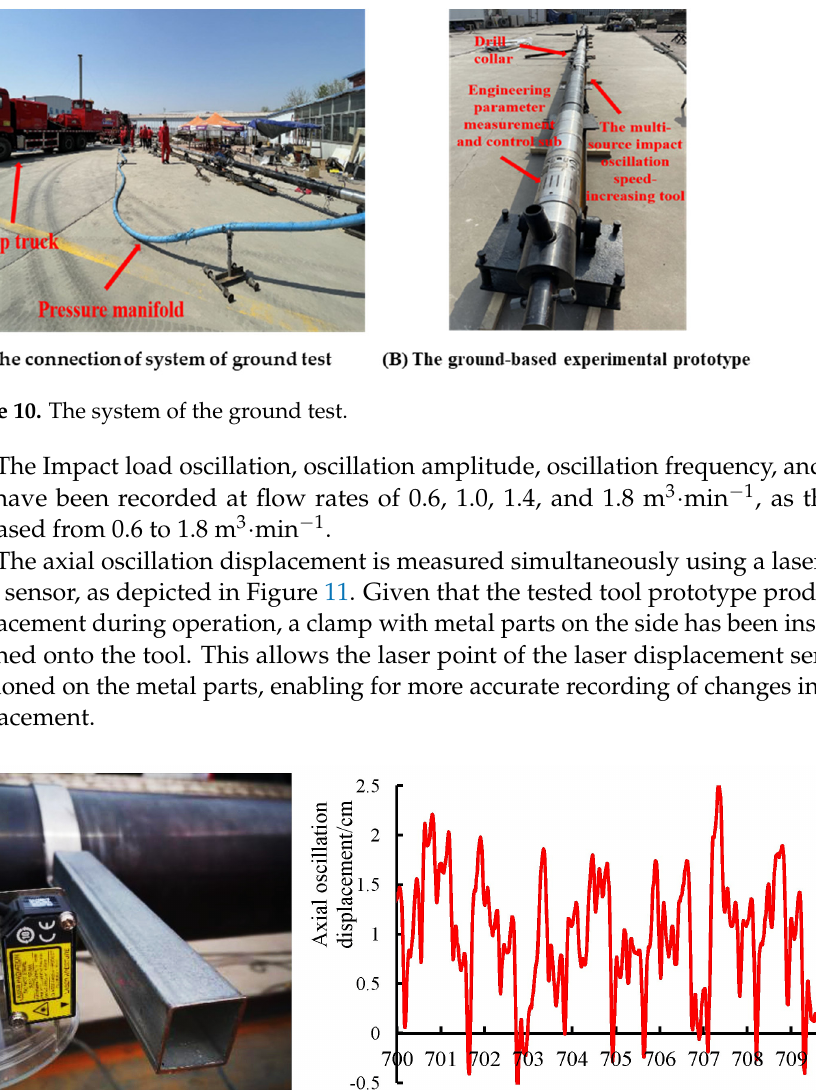
Figure 11. Position of the laser displacement sensor and curve of the impact displacement.